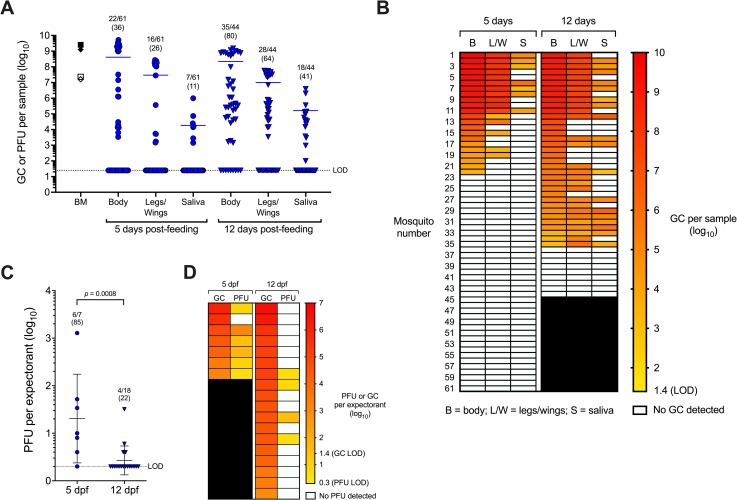
Vector competence of Aedes aegypti from Los Angeles for Indian Ocean Lineage CHIKV.A) Viral RNA and infectious virus titers in bloodmeals (BM) and mosquito samples at 5 or 12 days post-feeding. Open symbols = CHIKV plaque-forming units (PFU), closed symbols = CHIKV genome copies (GC). For BM, symbol shapes represent replicate experiments. For mosquito samples, each symbol represents an individual mosquito, lines represent mean titers, and proportions of positive samples from total bloodfed mosquitoes are shown with percentages (in parentheses) above groups. B) Heatmap of GC per sample arranged by individual mosquitoes. C) PFU detected per expectorant at 5 or 12 dpf. D) Heatmap of GC and PFU per expectorant arranged by individual mosquitoes. Lines represent mean titers. LOD = limit of detection.